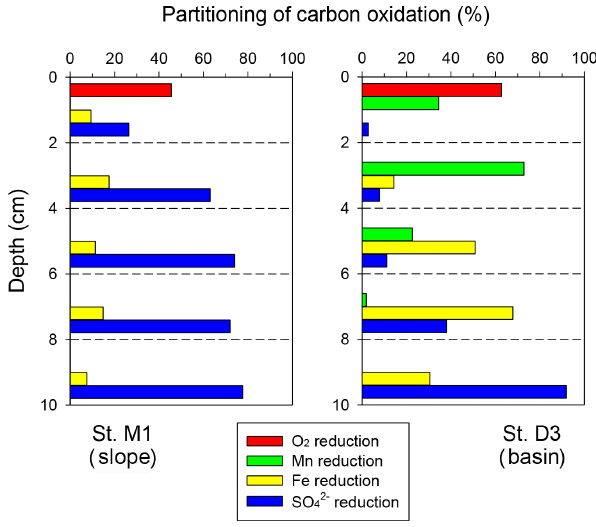
Figure 6. Depth variations in partitioning of each carbon oxidation pathway in total carbon oxidation at M1 and